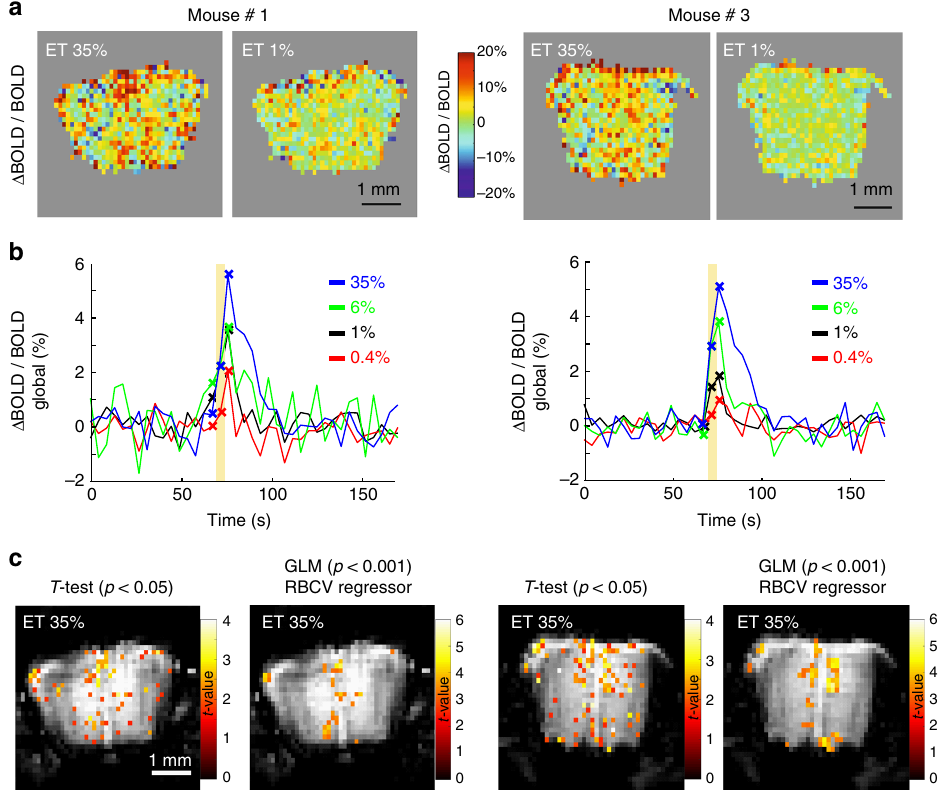
Fig. 6 BOLD-fMRI imaging of odour responses in the same mice. Left: mouse #1 (shown in Figs 4 and 5). Right: mouse #3 (shown in Fig. 3). a Δ BOLD/ BOLD signal voxel map within the OB mask (no threshold was applied). b Time course of the global Δ BOLD/BOLD signal (comprising all voxels). The response amplitude and duration increases with the odour concentration. Crosses indicate the individual data points before and after odour onset, showing that response occurs after the onset of the odour application. c BOLD-fMRI activation maps for the two mice using two statistical approaches; Left: t -test ( p < 0.05); Right: the GLM (regressor: RBC velocity responses; a 2D smoothing was applied prior to regression, see Methods). In contrast to fUS activation maps, only few voxels are activated at 35%